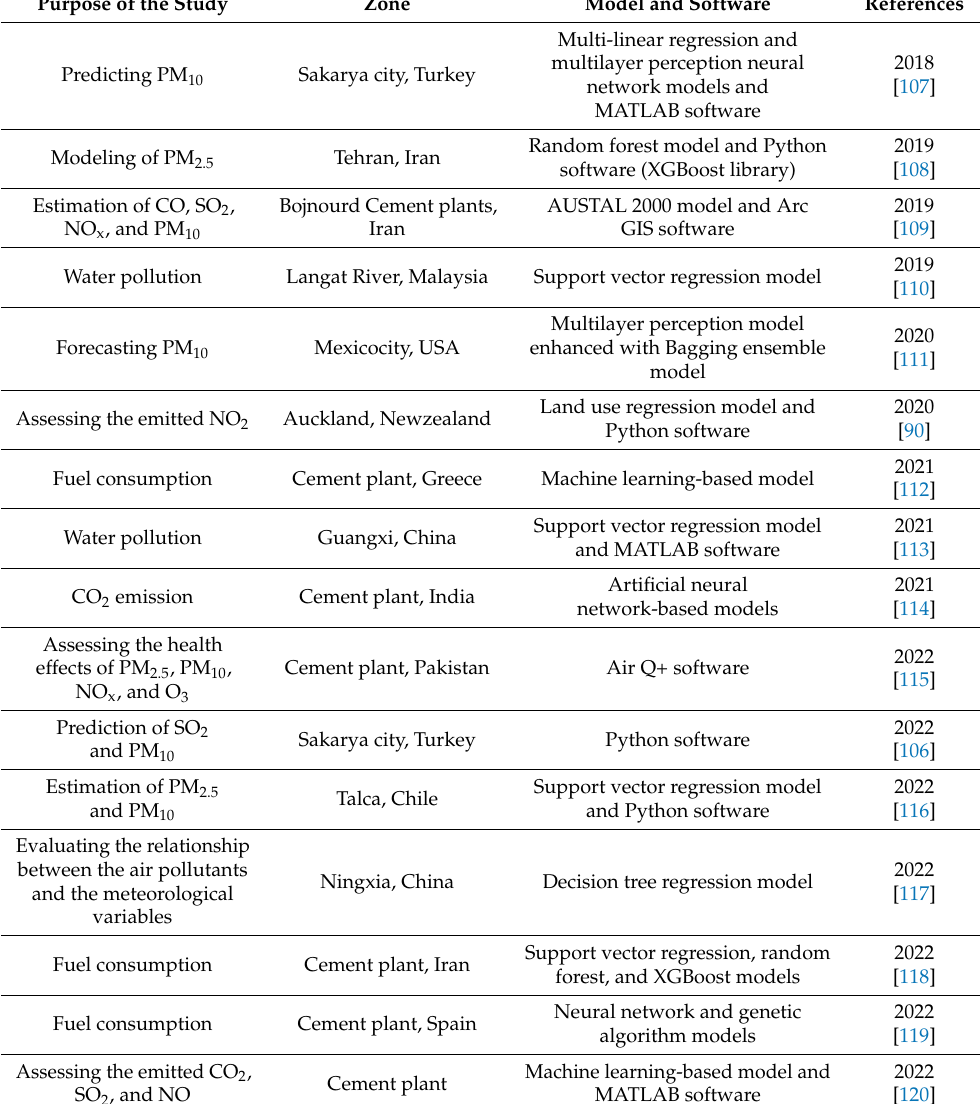
Table 3. Monitoring of industrial pollution using various modeling